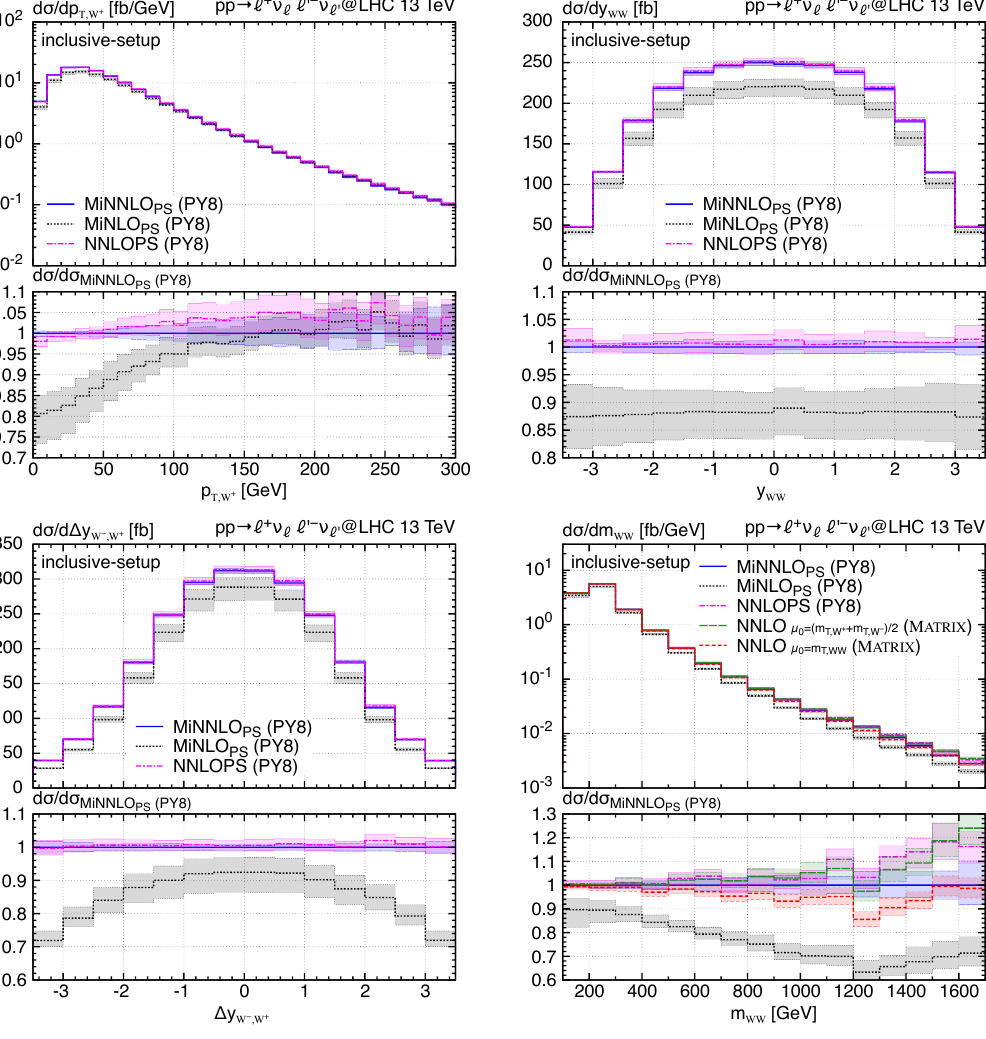
Figure 7. Differential distributions in the setup-inclusive